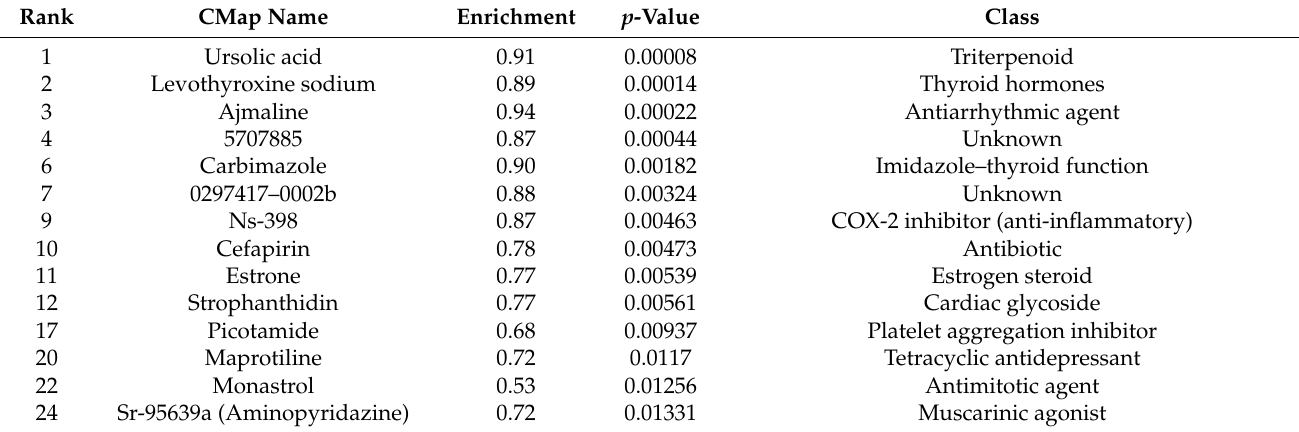
Table 3. Compounds that affect the expression of the gene expression signature genes similar to the five drugs that affected the Hippo pathway.